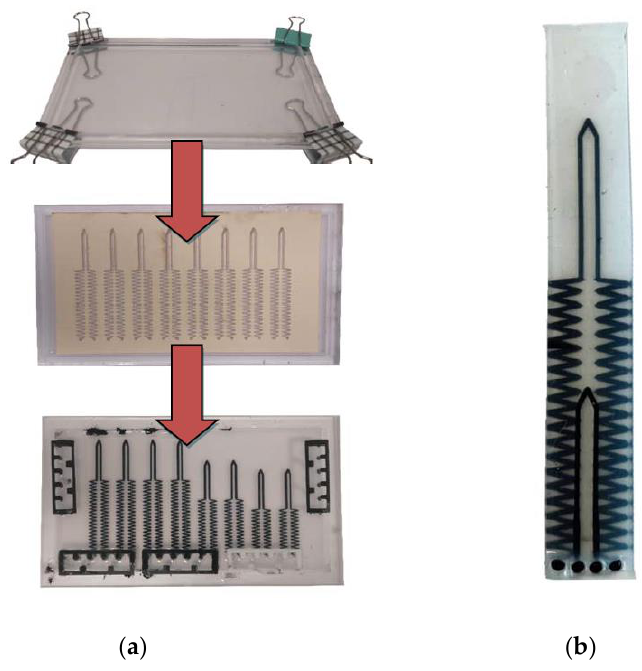
Figure 4. ( a ) Stages of fabricating sensor, ( b ) completed double-layer sensor.